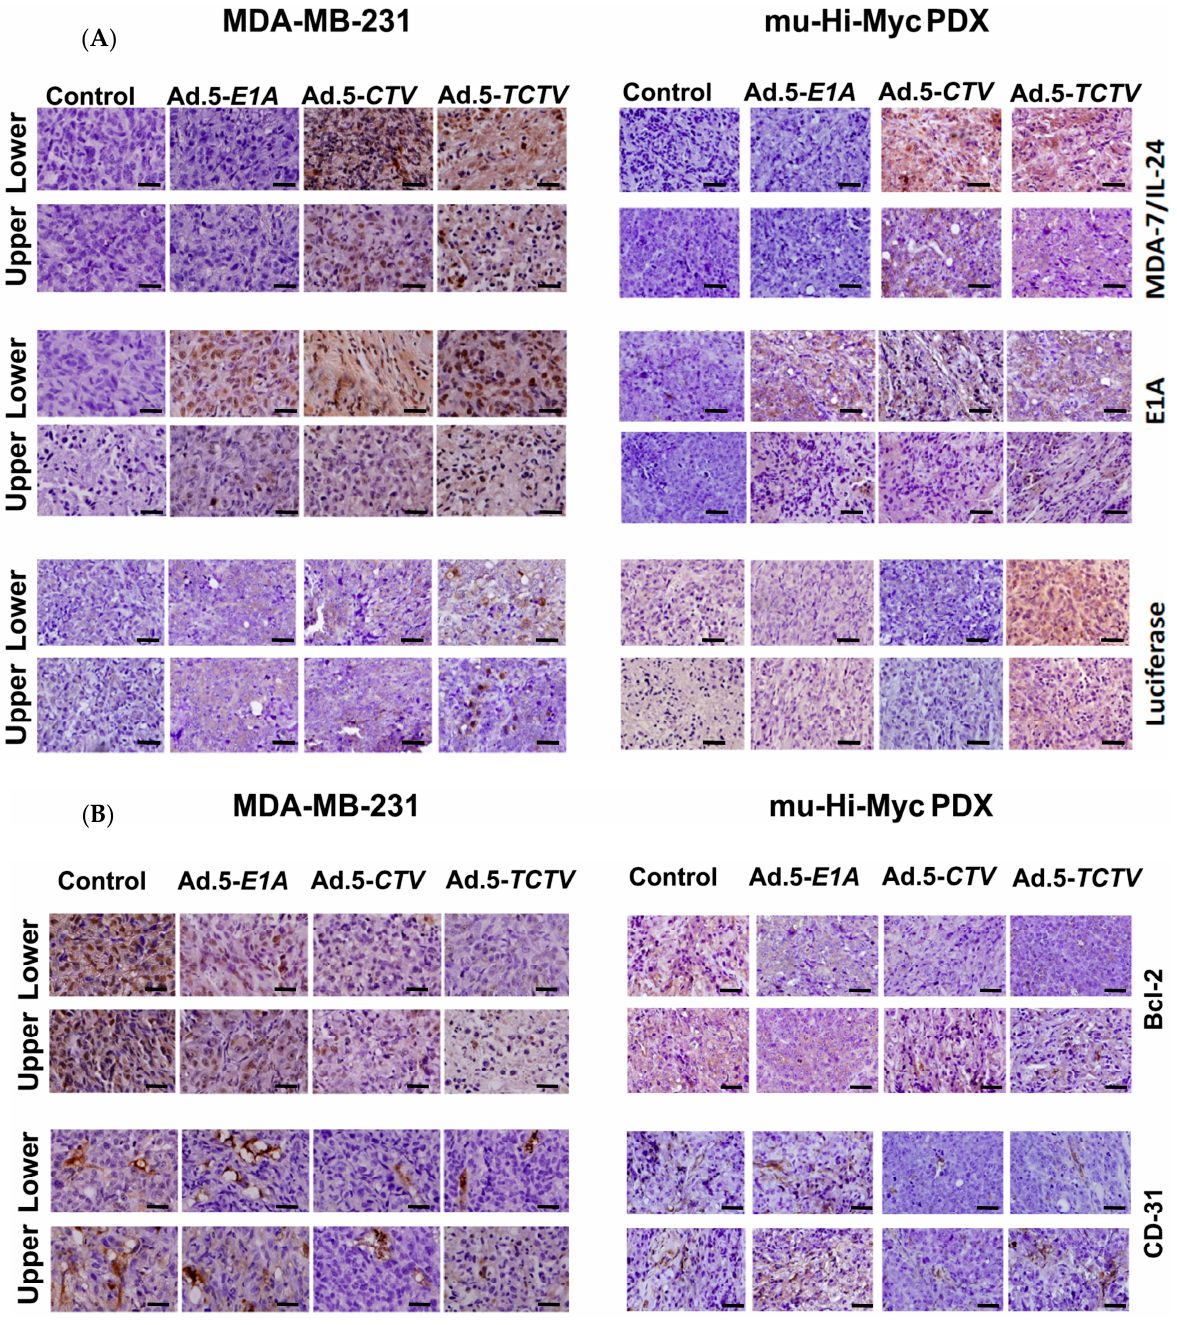
Figure 7. Ad.5- TCTV induces apoptosis and inhibits angiogenesis in vivo. MDA-MB 231 and mu-Hi-Myc PDX cancer cells were implanted subcutaneously in the lower and upper flanks of nude mice and the lower tumors were treated with eight intratumoral injections including solvent (mock treated control), Ad.5- E1A or Ad.5- CTV or Ad.5- TCTV . A total of five animals were studied in each group. Once the control animals’ tumors reached maximum allowable limit, tumors were collected, fixed in formalin, and embedded in paraffin. ( A ) Immunohistochemical (IHC) analysis of MDA-7/IL-24, adenovirus E1A, and Luciferase from tumor sections as indicated. ( B ) IHC analysis of Bcl-2 and CD-31 from tumor sections as indicated. Scale bar: 200 μ M.